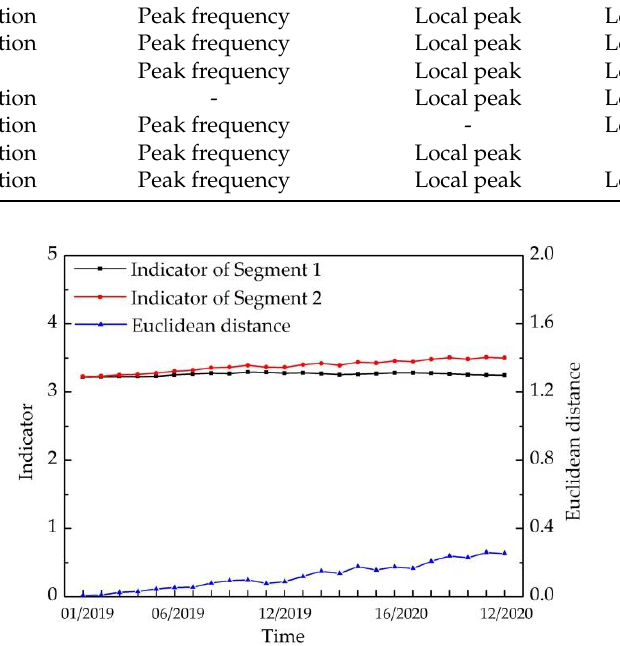
Figure 21. Indicators of Segment 1 and Segment 2 and their Euclidean distance.